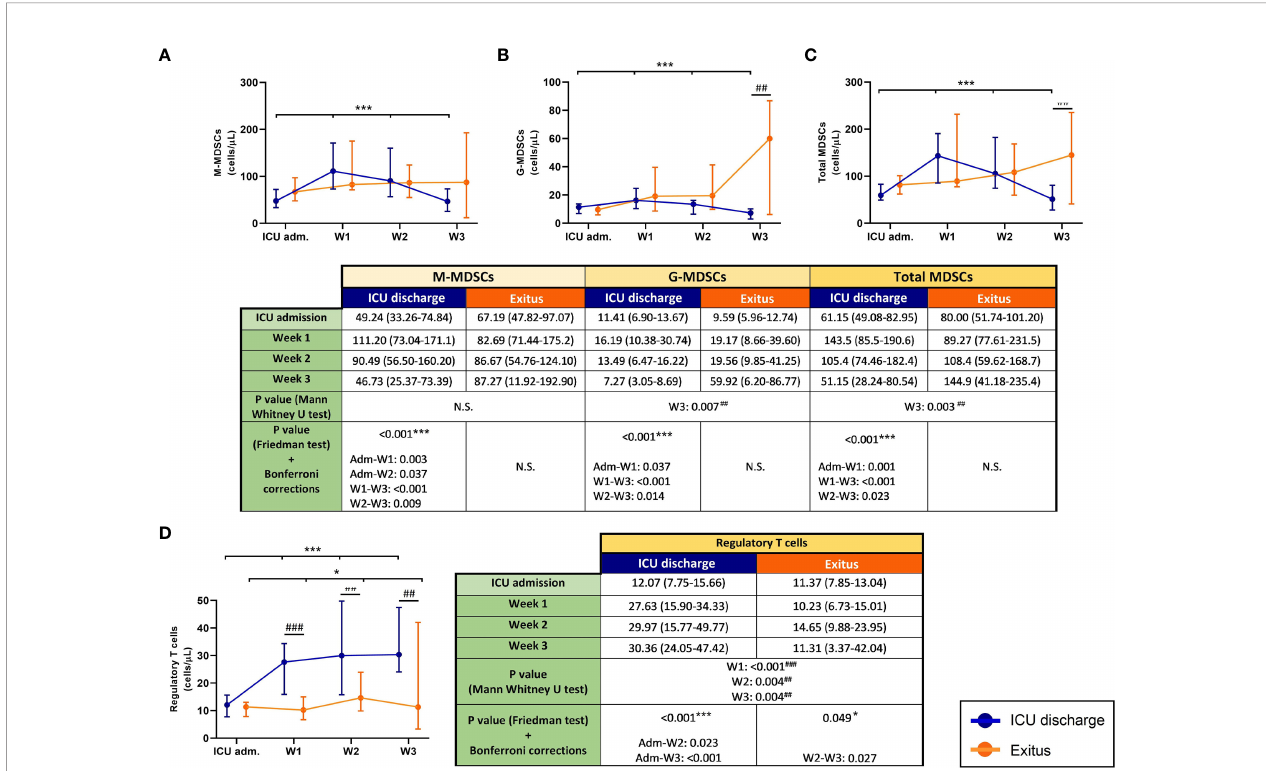
FIGURE 1 | Circulating myeloid-derived suppressive cells (MDSCs) and regulatory T cells (Tregs) in discharged ( blue ) and deceased ( red ) coronavirus disease 2019 (COVID-19) patients during their follow-up in the ICU. (A) Monocytic MDSCs. (B) Granulocytic MDSCs. (C) Total MDSCs. (D) Tregs. All data shown are the median and 95% con fi dence intervals of cells per microliter. ## p ≤ 0.01, ### p ≤ 0.001 comparing opposite groups, respectively; * p ≤ 0.05, *** p ≤ 0.001 compared with ICU admission, respectively. ns, not signi fi